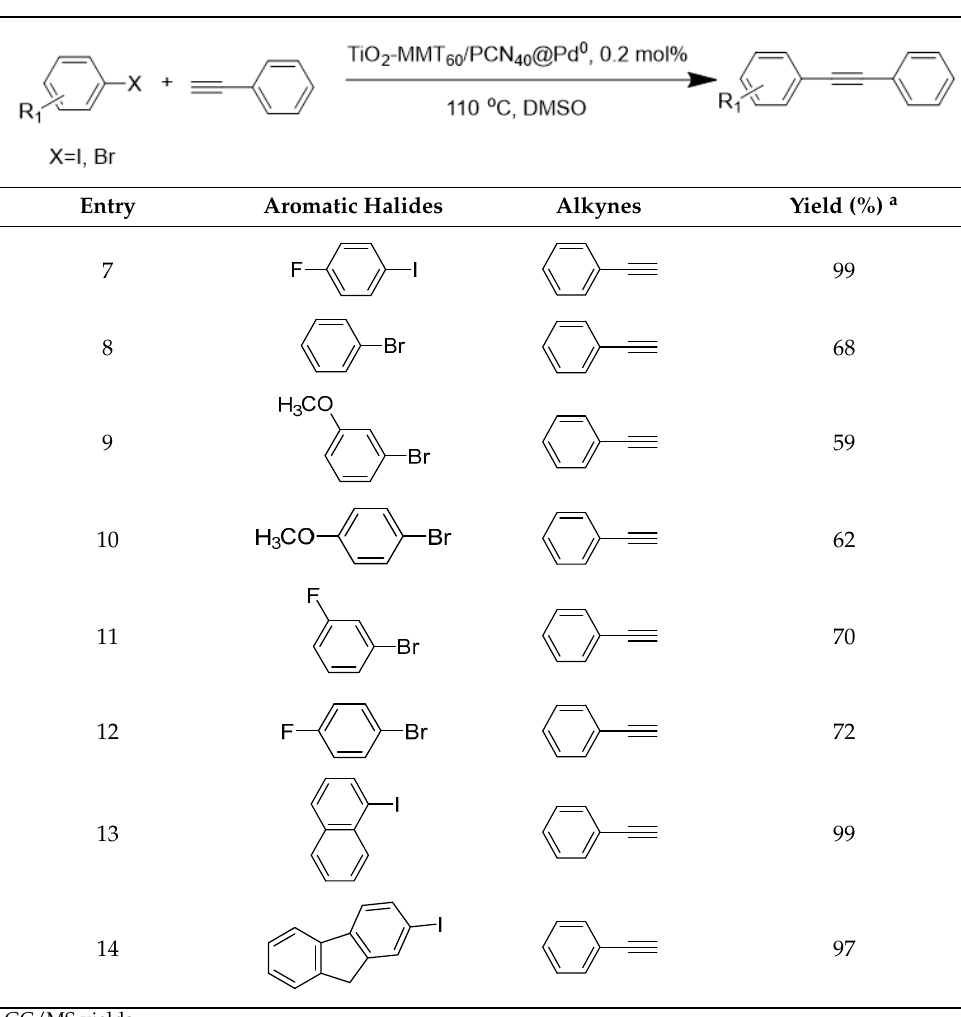
coupling reactions between aromatic halides and alkynes. Table 4. Cont.